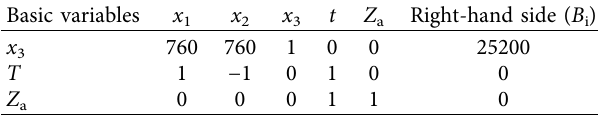
Table 1: The initial Simplex table.